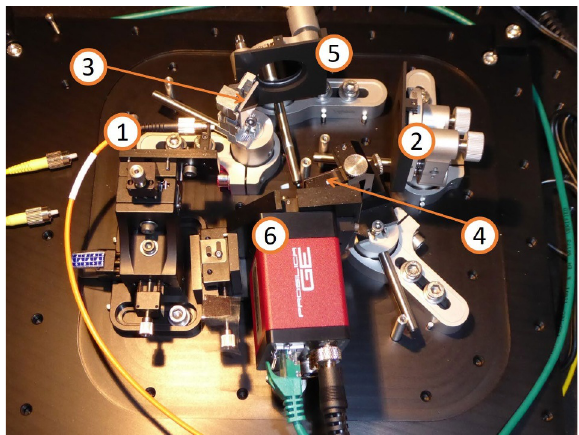
Fig. 1. Photograph of the realized spectrometer. The different mounted components are labelled with the following numbers: fiber (1), collimating mirror (2), toric correction mirror (3), cross-grating (4), focusing mirror (5) and detector (6).